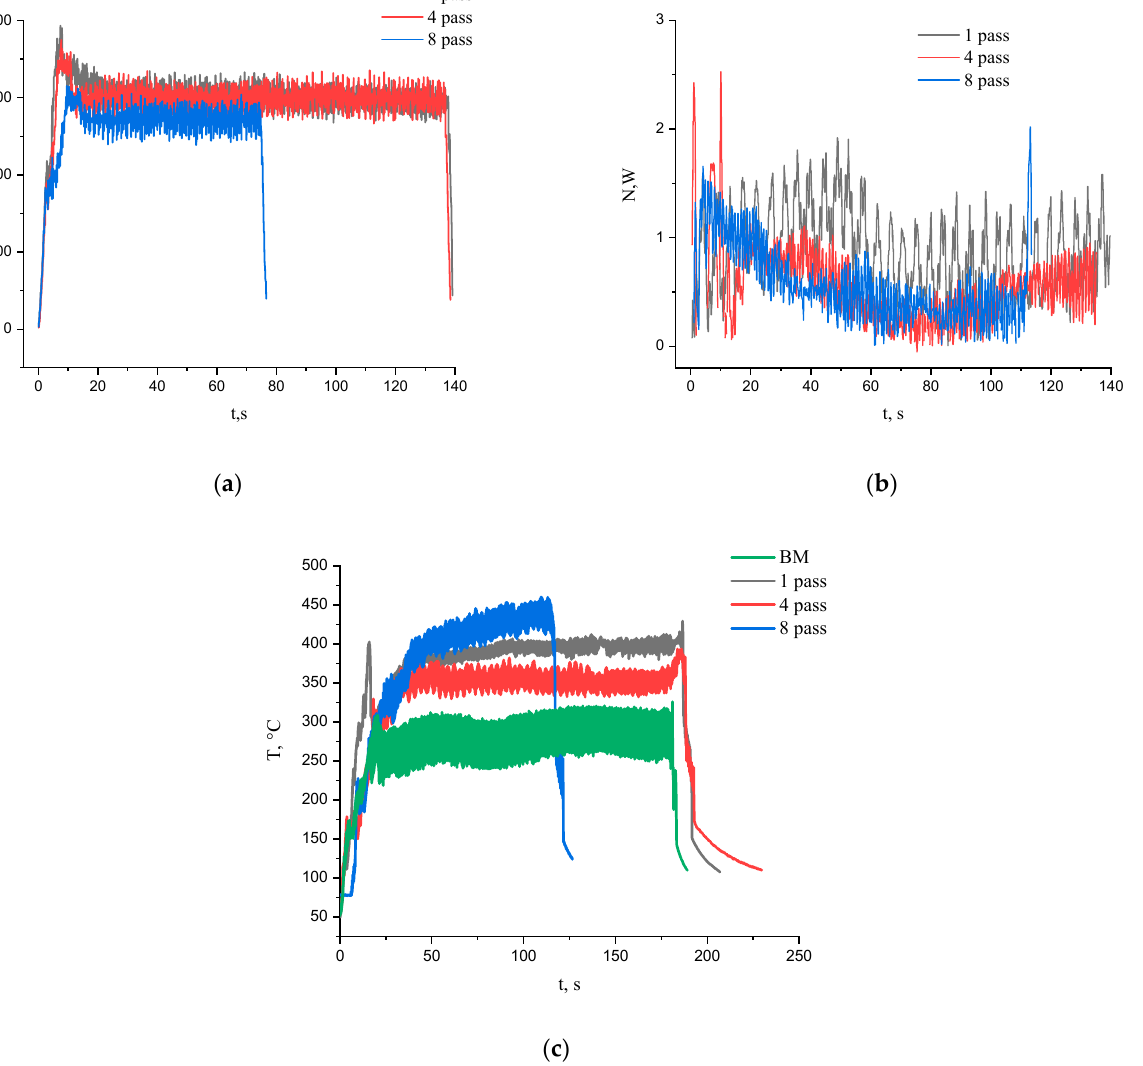
Figure 3. Torque power ( a ), reaction force power ( b ) and surface temperature ( c ) dependencies vs. FSP pass times.